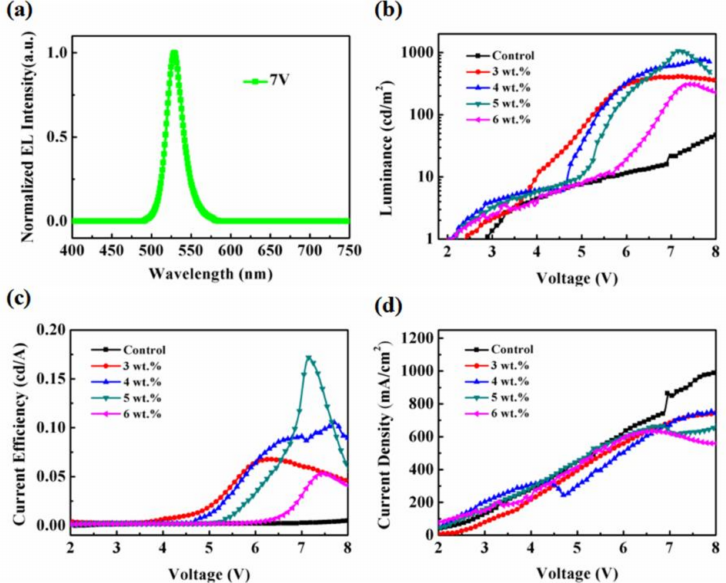
Figure 5. ( a ) Normalized EL spectra of PeLEDs at 7 V. ( b ) Luminance versus voltage curves of PeLEDs. ( c ) Current efficiency versus voltage curves of PeLEDs. ( d ) Current density versus voltage curves of